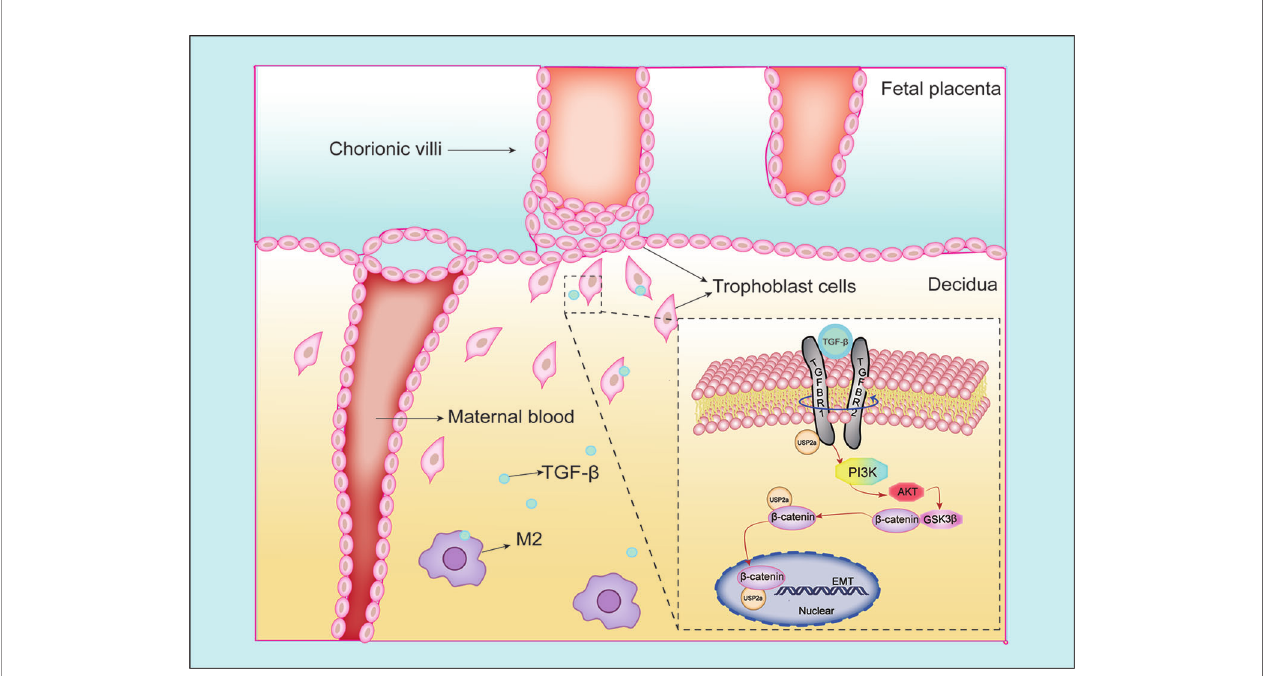
FIGURE 7 | Schematic diagram of the interaction between trophoblasts and macrophages at the maternal-fetal interface. Our study illustrated USP2a facilitates the EMT programme to enhance migration and invasion of trophoblasts secreted by phosphorylating PI3K/Akt/GSK3 b / b -catenin signaling pathways. In the meantime, USP2a could interreact with b -catenin as a “ shortcut ” to promote nuclear b -catenin accumulation. TGF- b secreted by M2 macrophage could work together with USP2a to promote trophoblast invasion. Thereby, USP2a participates in regulating the establishment and maintenance of normal